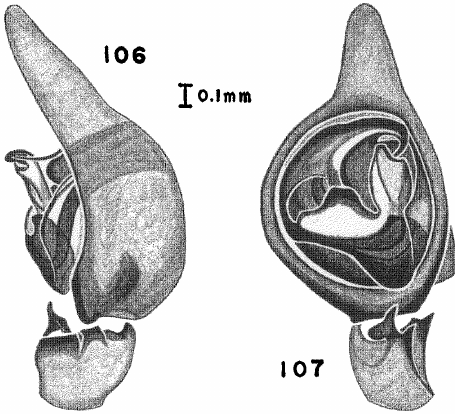
Figs. 106-107. OxyoIes flaous Banks, male from Tierra Colorado, Guer- rero, 23 July 1972. 106. Left palpus, retrolateral view. 107. Left palpus, ventral